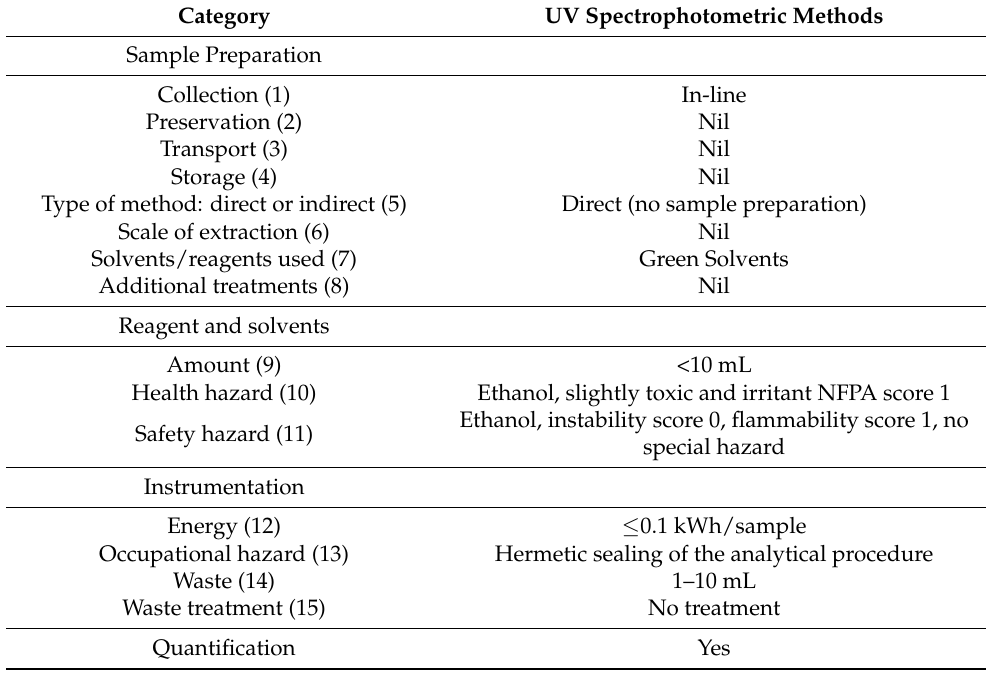
Figure 5. ( A ) Greenness evaluation results of the proposed method by Raynie et al.’s method [33]. ( B ) The GAPI method. Table 4. The GAPI evaluation results for the spectrophotometric Table 4. The GAPI evaluation results for the spectrophotometric methods.